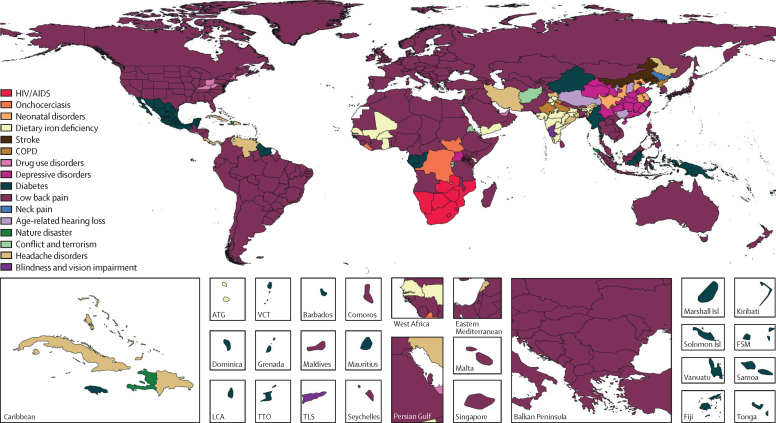
Leading Level 3 causes of age-standardised YLD rates by location for both sexes combined, 2017ATG=Antigua and Barbuda. COPD=chronic obstructive pulmonary disease. FSM=Federated States of Micronesia. Isl=Islands. LCA=Saint Lucia. TLS=Timor-Leste. TTO=Trinidad and Tobago. VCT=Saint Vincent and the Grenadines. YLD=years lived with disability.